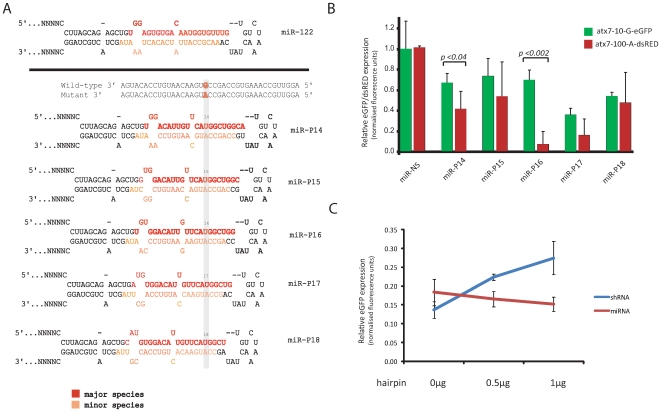
Knockdown of targets using pri-miRNA-based hairpins.A) Guide strands in pri-miRNA format, with sequences of mismatch guide strands processed from a miRNA format indicating the site of the primary mismatch to the G allele of the wild-type atxn7 target. Sequence context of both the wild-type and mutant targets are shown. The miRNAs were labelled according to the position of the primary mismatch relative to the 5′ end of the guide strand. Major species refers to the strand most likely to be incorporated by RISC, while the minor species indicates the strand less likely to be incorporated. B) Knockdown of targets in a heterozygous assay using miRNAs. Quantification of fluorescence in HEK293 cells co-transfected with wild-type atx7-10-G-eGFP and mutant atx7-100-A-DsRED expression plasmids and the indicated miRNA. The data is relative to that measured using a non-specific miRNA, NS. Average±standard deviation is shown. Statistically significant differences (p<0.05) between wild-type and mutant silencing are indicated by using the one-tailed t-test. Wild-type and mutant targets are represented by green and red bars respectively. C. Increased addition of an shRNA but not a miRNA hairpin interferes with post-transcriptional gene silencing machinery. Low levels of a GFP target plasmid and GFP specific hairpin result in knockdown of GFP relative to a non-specific hairpin in the presence of 1 µg of empty vector, either pU6+1 or pCI_neo (vectors which contain the promoters used to transcribe shRNA and miRNA hairpins respectively). The shRNA data is relative to that measured using a non-specific shRNA, NS, while the miRNA data is relative to that measured using a non-specific miRNA, NS. The shR-E19 hairpin was pE19; a published U6/shRNA expression plasmid targeting GFP (37). Average±standard deviation is shown. Each experiment was performed in triplicate.